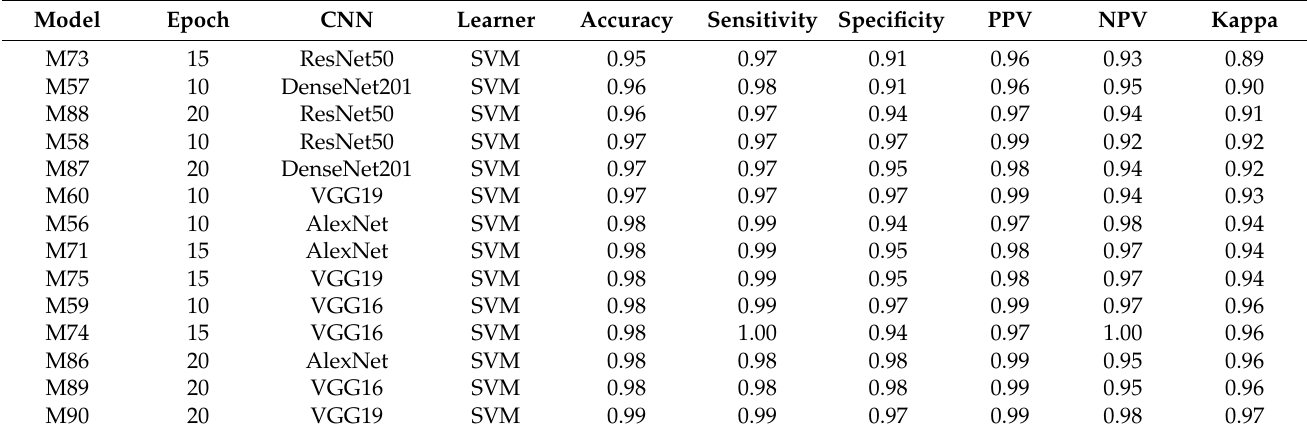
Table 4. Models trained with 70% of the data achieved accuracy and kappa values of no less than 0.95 and 0.88, respectively.